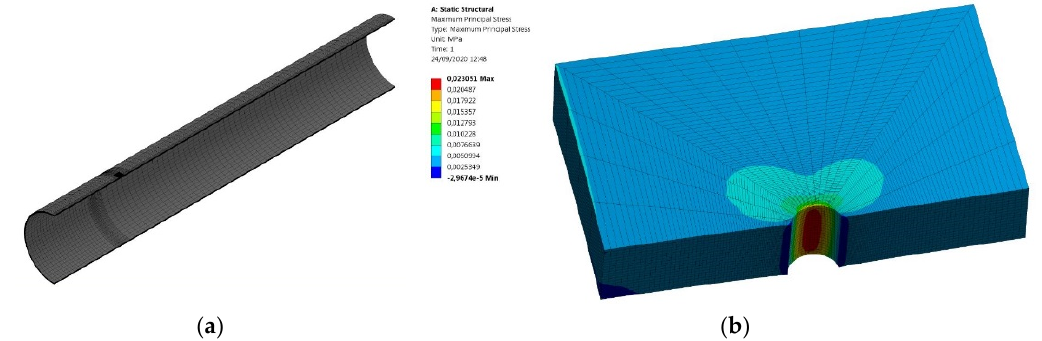
Figure 7. ( a ) Mesh employed in the FEA (finite element analysis) of the tubular beams; ( b ) detail of the notch tip.